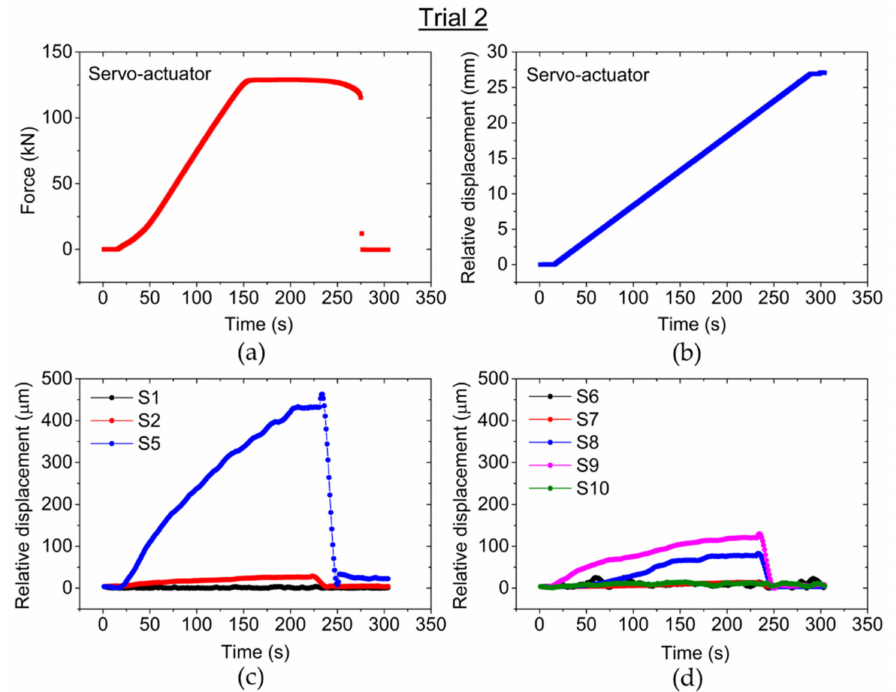
Figure 7. Experimental results from Trial 2: ( a ) Applied force to the RB during the pull-out test. ( b ) Relative displacement from the servo-actuator. ( c , d ) Relative displacement measured by the optical sensors during Trial